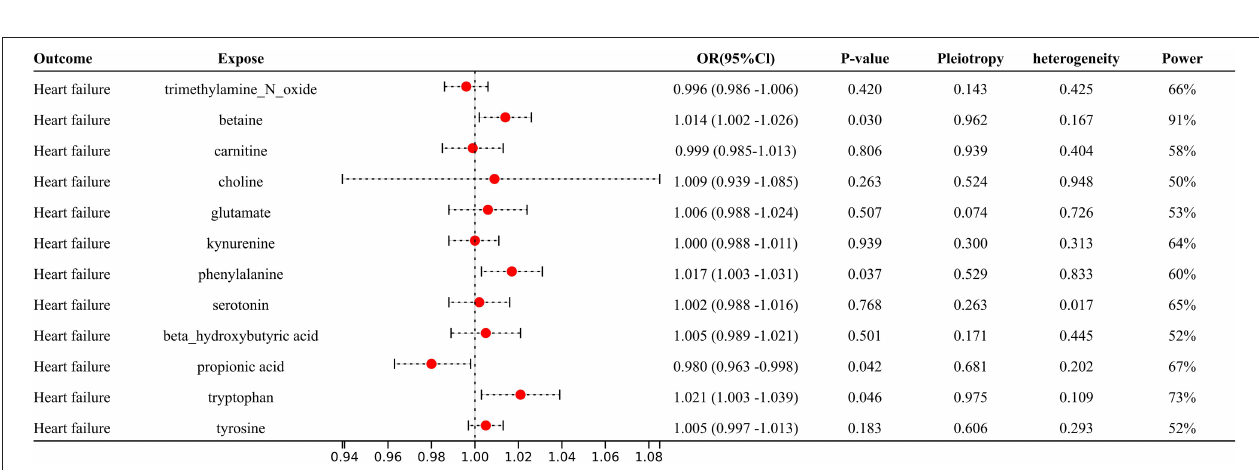
FIGURE 4 | Forest plot to visualize the causal effect of Gut metabolites on the risk of heart failure by inverse variance weighted